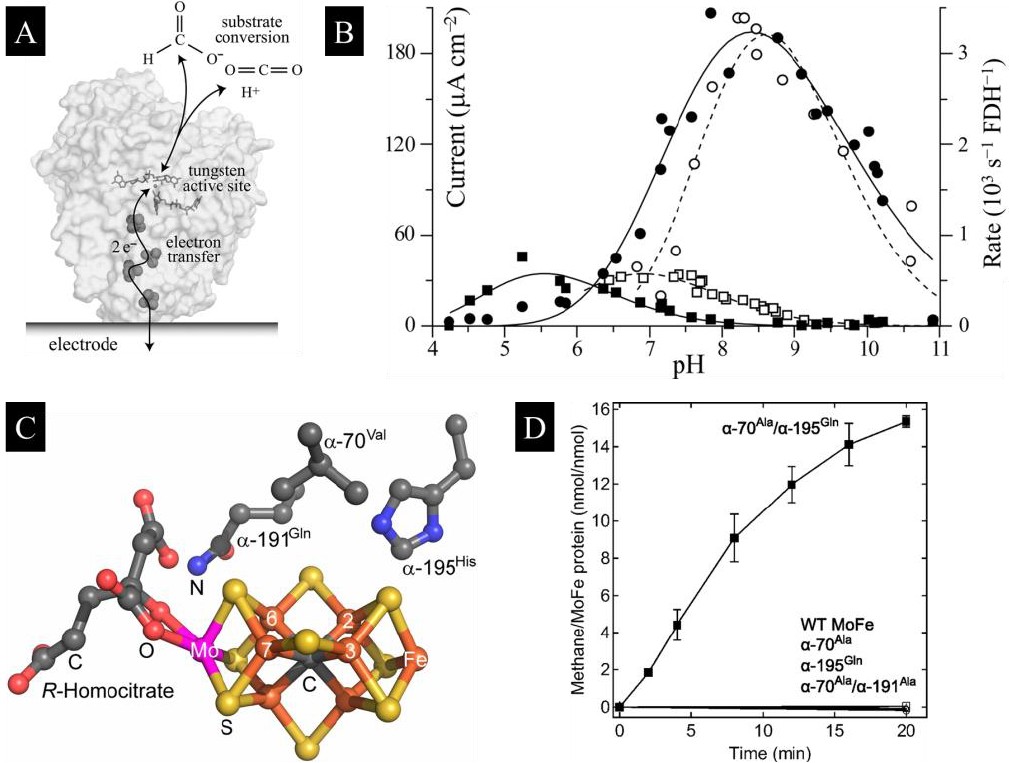
Figure 2. ( A ) Schematic of catalytic interconversion between CO 2 and formate. ( B ) Kinetics of catalytic reaction by tungsten containing FDH as a function of pH value [41]. Copyright (2012) Yang et al. ( C ) FeMo cofactor with some key amino acid residues [49]. ( D ) CH 4 formation as a function of time for different MoFe proteins [49]. Copyright (2008) National Academy of Sciences, USA.